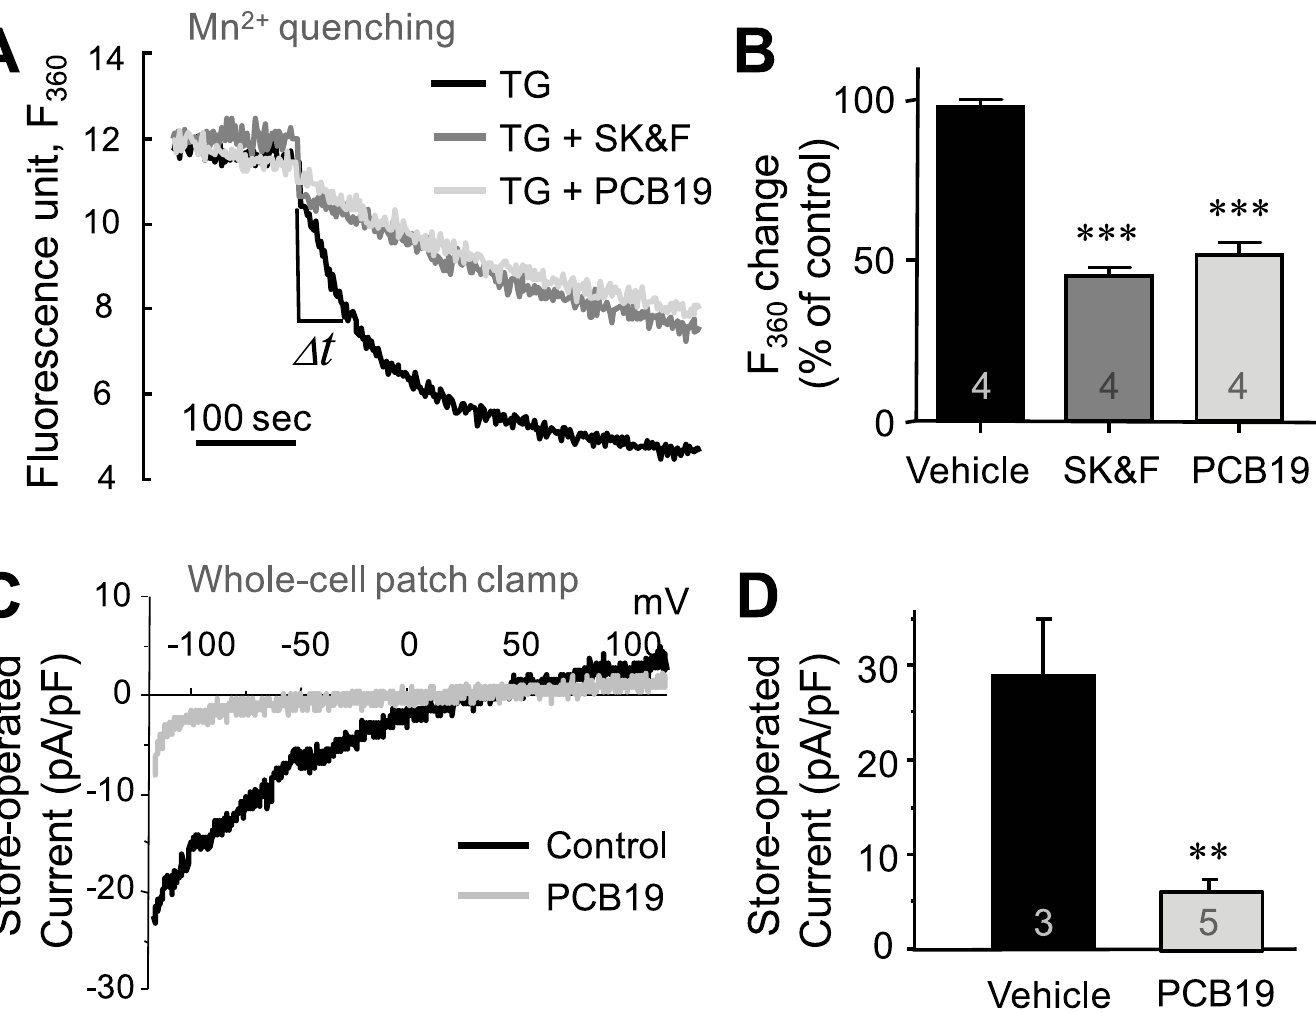
Fig 7. PCB19 inhibits store-operated cation entry. A , Mn 2+ -induced fura-2 fluorescence quenching was recorded in fura-2/AM-loaded PC12 cells. The fluorescence intensities at 360 nm (F 360 ) was monitored with 1 mM MnCl 2 (arrow), after the preincubation of thapsigargin (TG) with PCB19 or SK&F96365 (SK&F) in the absence of extracellular free Ca 2+ . B , The changes in time ( Δ t) during the fluorescence changes (arbitrary units) were quantitatively analyzed with the results in A . C, Ca 2+ store depletion-induced cation influx was measured in PC12 cells with whole-cell patch clamp experiments. Currents were activated following dialysis with 10 mM BAPTA and ramp pulses of membrane potentials from -100 to +100 mV were applied to monitor SOCE current. Typical traces of Ca 2+ store depletion-induced cation influxes with (gray trace) and without (black trace) 50 μ M PCB19 are depicted. D, Comparison of average peak store-operated current densities (pA/pF). Number of experiments are depicted in bar graph and each point represents mean ± SEM. ** P <